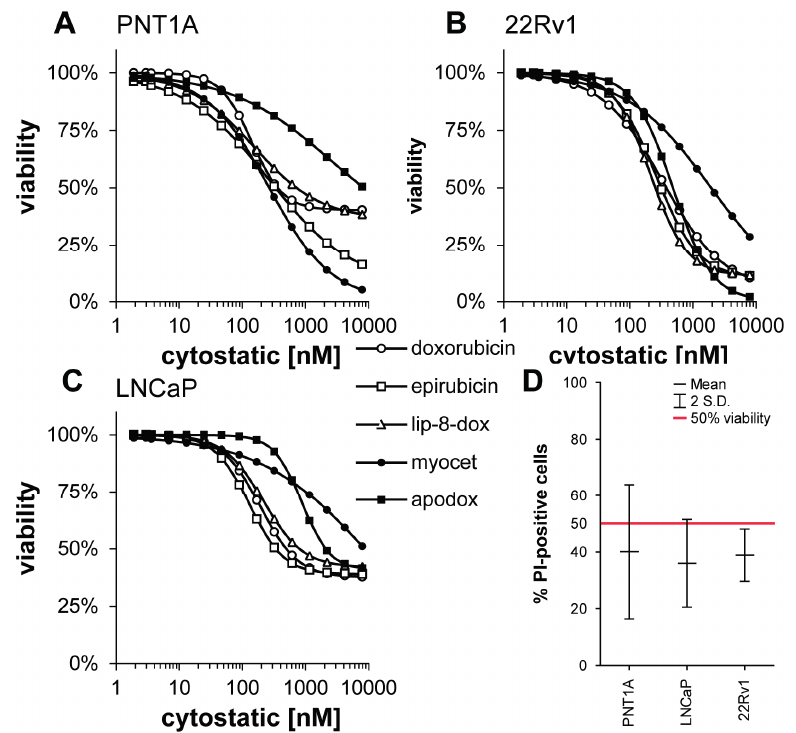
Figure 4. Determination of viability of prostatic cell lines treated with modified forms of doxorubicin using MTT assay ( A – C ); ( D ) verification of real-time cell impedance-based cell growth method (RTCA)-determined IC 50 value. Red line indicates theoretical 50% viability. No significant difference was observed using one sample t